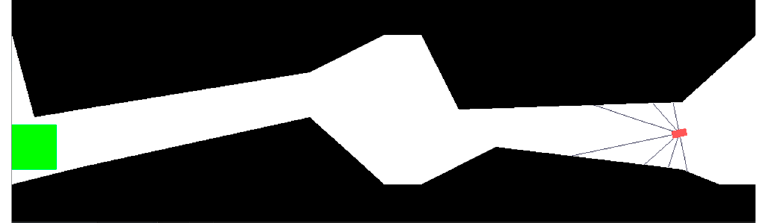
Figure 7. Environment 1. : The walls of unknown underwater canyon;